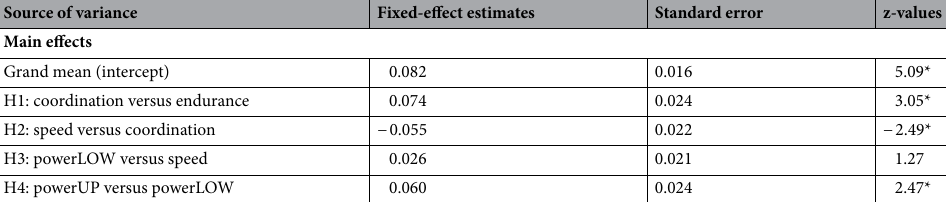
Table 4. Fixed-effect estimates of the linear mixed model for younger-than-keyage (YTK) children. H1– H4 = hypothesis 1–4, endurance = cardiorespiratory endurance (i.e., 6 min run test), coordination = star run test, speed = 20-m linear sprint test, powerLOW = lower limbs muscle power (i.e., standing long jump test), powerUP = upper limbs muscle power (i.e., ball push test), * = z-value > 2.0, linear mixed model random factors: schools (437), children (2586), observations = 12,590 (missing = 2.6%). For estimates of variance components and correlation parameters see Table 5.